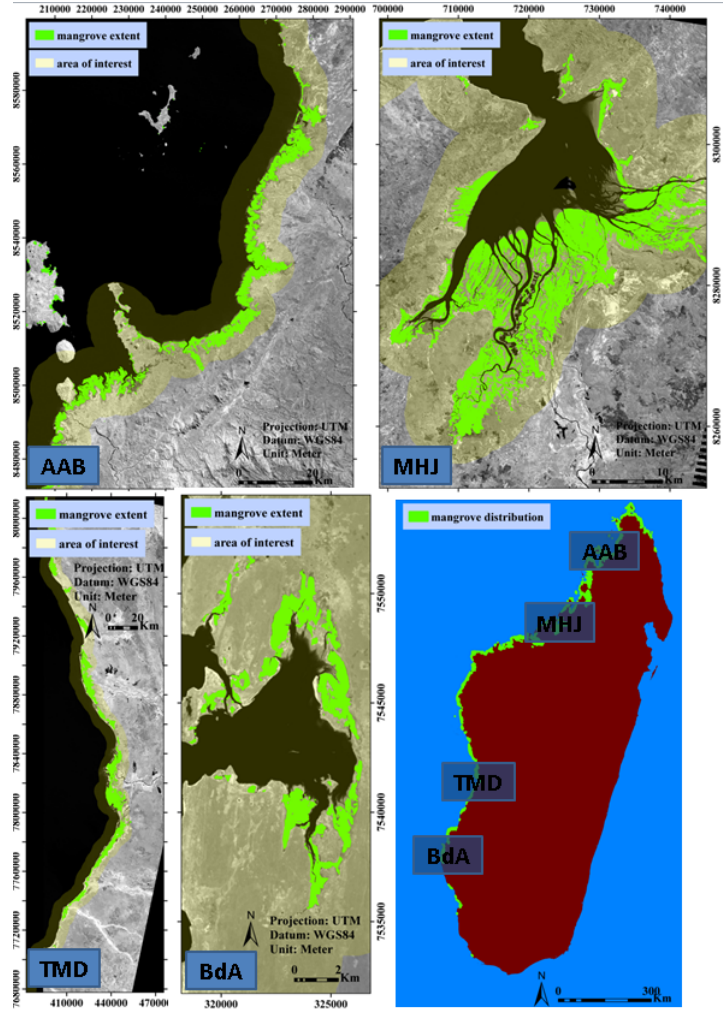
Figure 1. The study area includes the entire distribution of Madagascar’s mangroves (shown in green, circa 2010, bottom right) (data obtained with permission from Giri [69]). The combined marine and terrestrial extent within 7 km from the coast in four primary mangrove ecosystems ( i.e. , Ambaro-Ambanja Bays (AAB), Mahajamba Bay (MHJ), Tsiribihina-Manambolo Delta (TMD) and the Baie des Assassins (BdA)) represent four specific areas of interest (AOIs). The location of each AOI is shown in the country-wide inset (bottom right). Mangrove extent ( circa 2010) within each AOI is shown in green (data obtained with permission from Giri [69]). shown in green (data obtained with permission from Giri